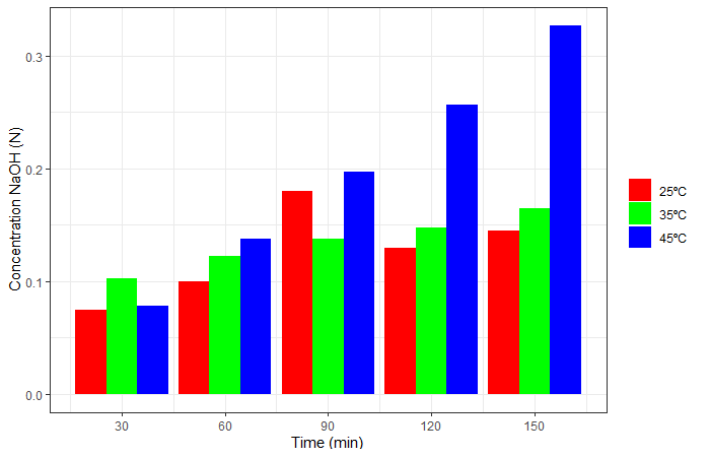
Figure 6. Effect of temperature at 6.5 V and 0.05 N with NaOH